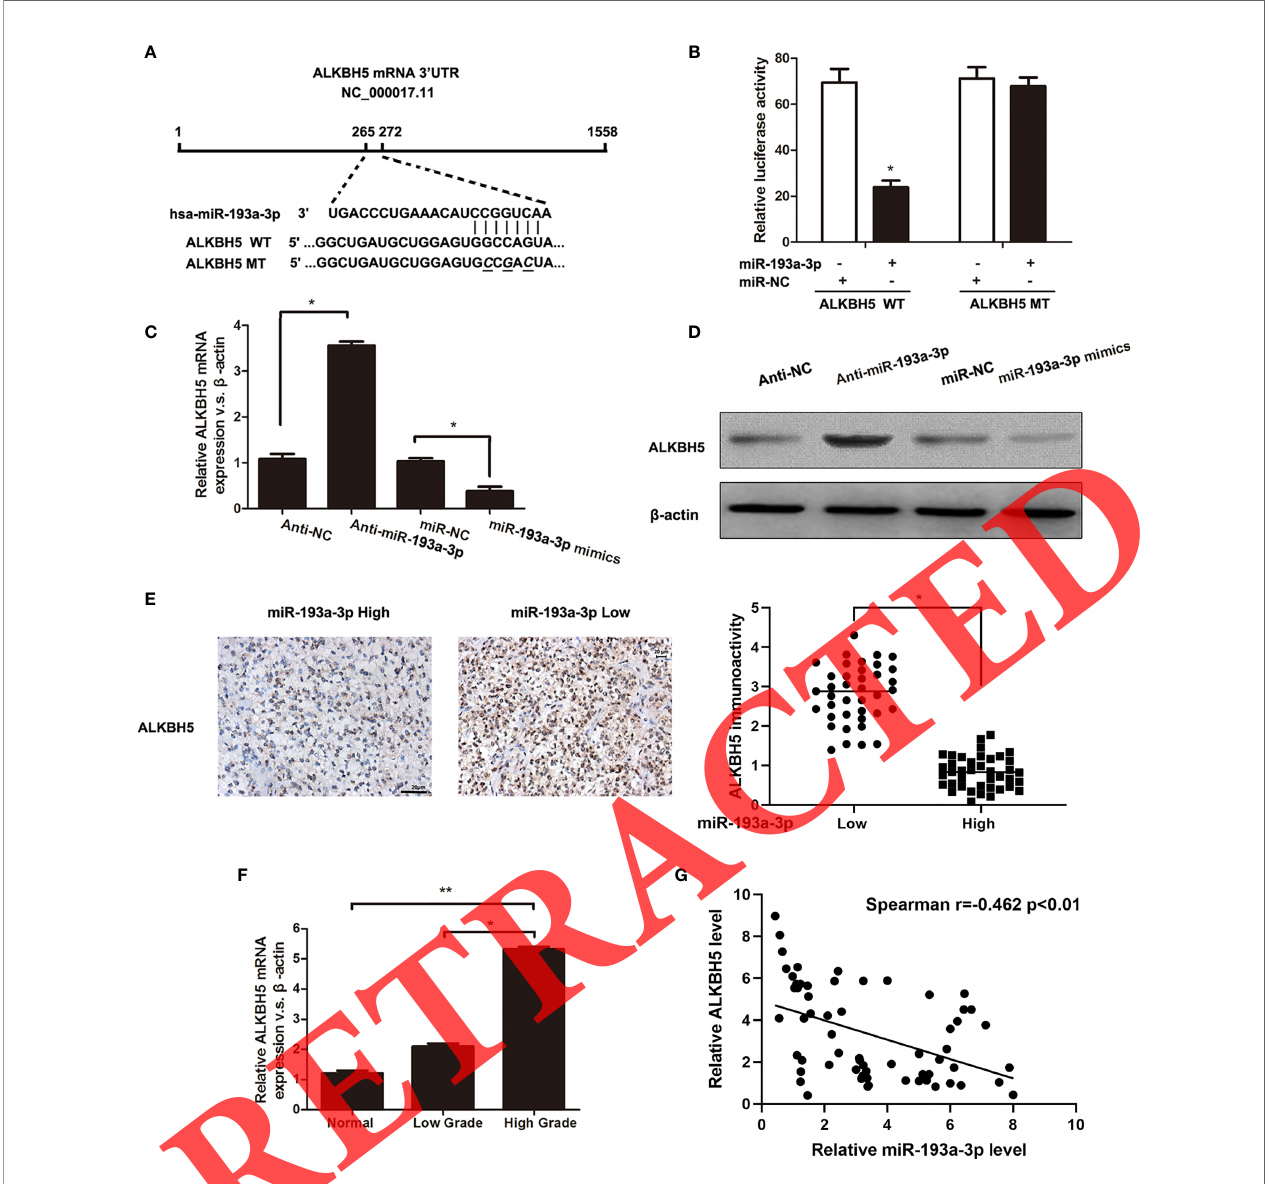
FIGURE 3 | (A) Sequence of wild type and mutant miR-193a-3p target sites in the ALKBH5. (B) The analysis of the relative luciferase activities of ALKBH5-WT, ALKBH5-MT in U87 glioma cells. *P<0.05. (C) Relative ALKBH5 mRNA levels in U87 cells transfected with miR-NC, miR-193a-3p mimics, anti-NC and anti-miR-193a-3p. *P<0.05. (D) ALKBH5 protein levels were determined by Western blot in U87 cells transfected with miR-NC, miR-193a-3p mimics, anti-NC and anti-miR-193a-3p. (E) Left: Representative immunostaining showed negative expression of ALKBH5 in miR-193a-3p high-expressing glioma tissues and positive expression of ALKBH5 in miR-193a-3p low-expressing tumor. Right: Quantitative analysis of Ki-67 immunoactivity. *P<0.05. (F) The expression levels of ALKBH5 mRNA in gliomas of different pathological grade were determined by qRT-PCR. *P<0.05 and **P<0.01. (G) Correlation between ALKBH5 mRNA expression and miR-193a-3p expression in human glioma tissues. r=-0.503,